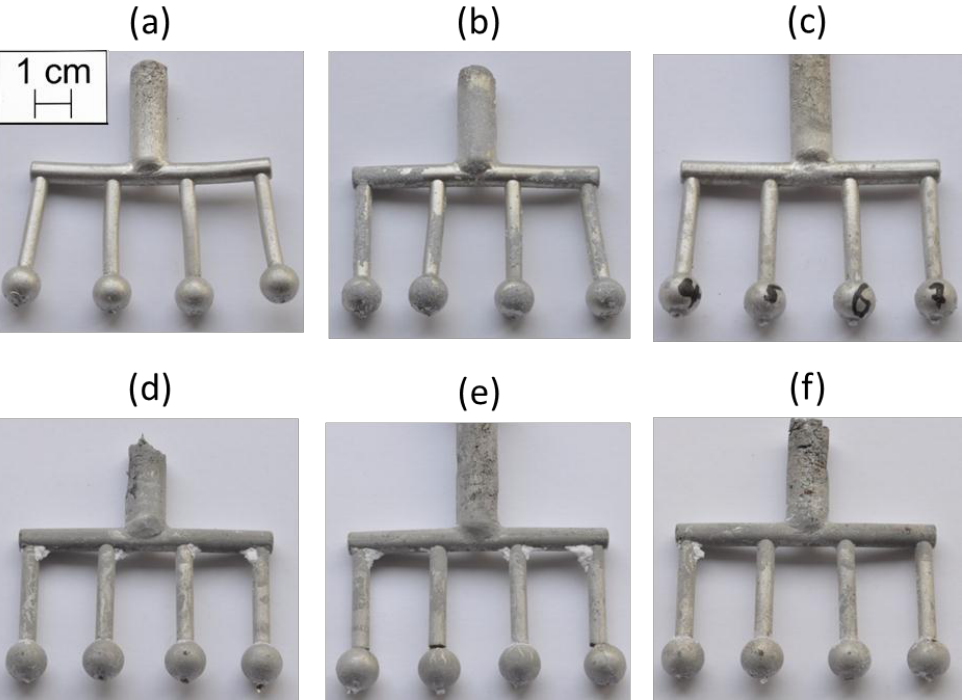
Figure 4. Samples of Ni2Re ( a ), Ni4Re ( b ), Ni9Re ( c ), Alloy1 ( d ), Alloy2 ( e ) and Alloy3 ( f ) after the temperature measurements. The shell mold was removed mechanically.